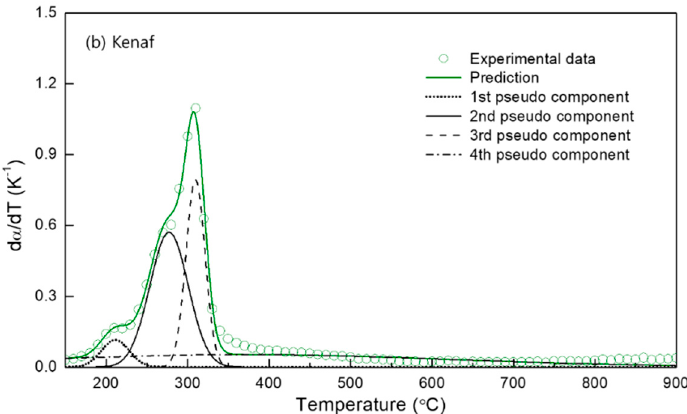
Figure 4. Experimental and calculated pyrolysis conversion rate curves for the biomass; ( a ) wood pellets and ( b ) kenaf.